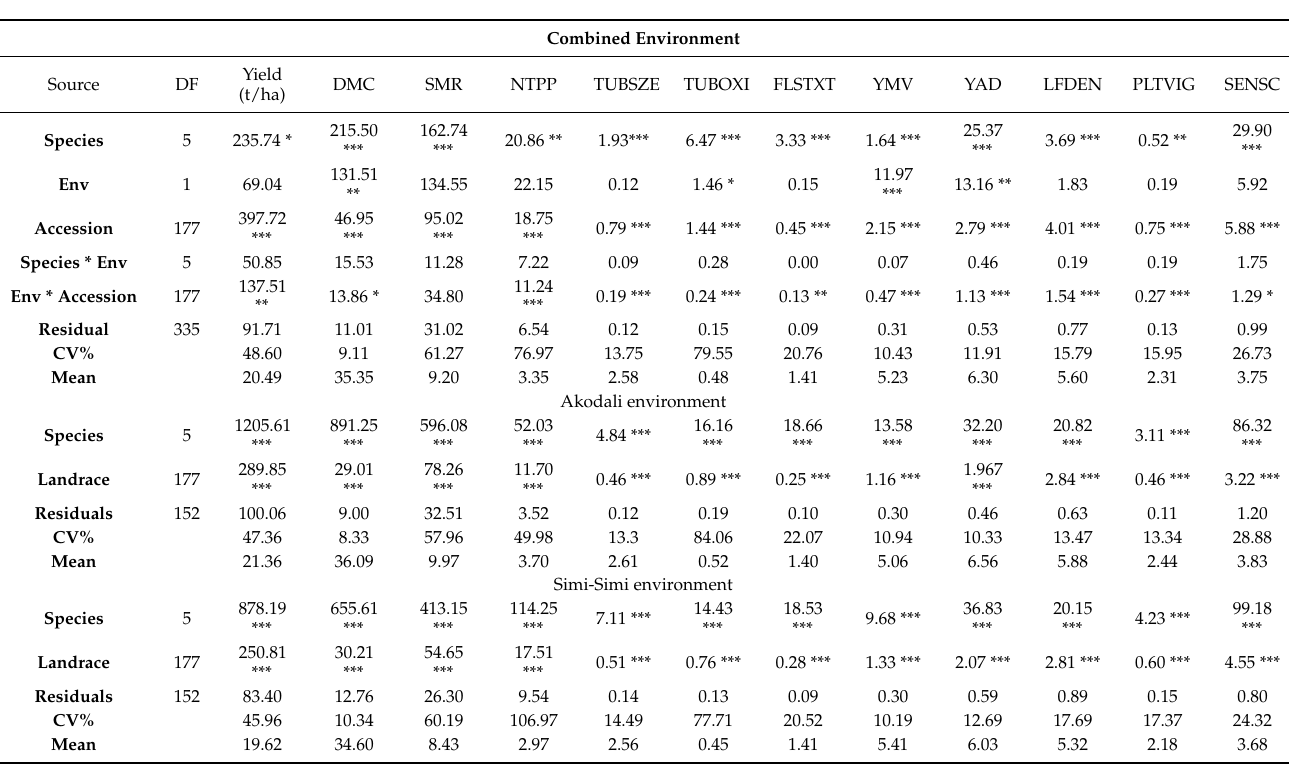
Table 3. Combined and environment specific mean squares for agronomic and tuber quality traits in yam